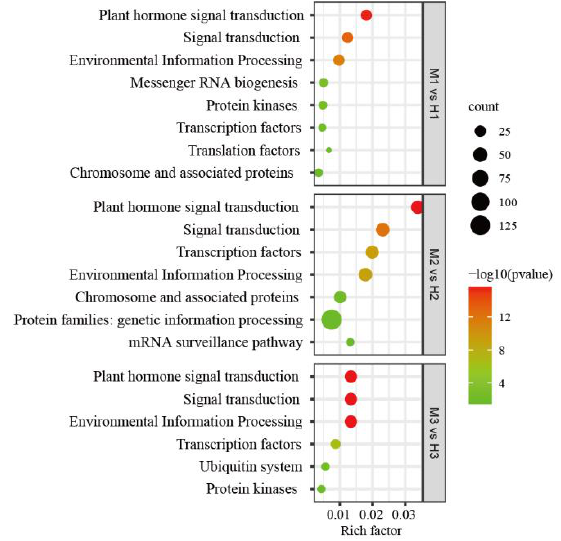
Figure 4. KEGG pathway analysis of target genes predicted by differentially expressed miRNAs in three stages. M1 vs. H1, M2 vs. H2, M3 vs. H3 indicate the first, second and third stage, respectively.